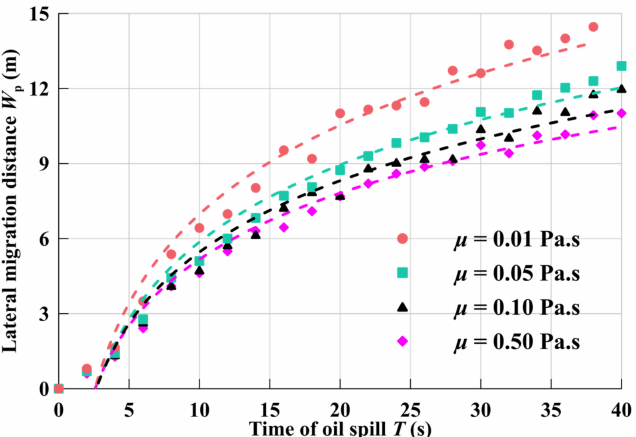
Figure 13. Lateral migration distance of spilled oil for four different oil